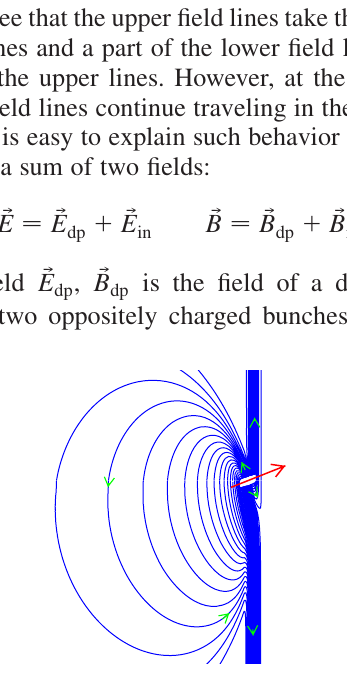
FIG. 3. Detailed structure of the field pattern. The red arrow shows the direction of the bunch velocity. Green arrows show the field line direction. Upper field lines take the position of the lower lines and a part of the lower field lines take the position of the upper